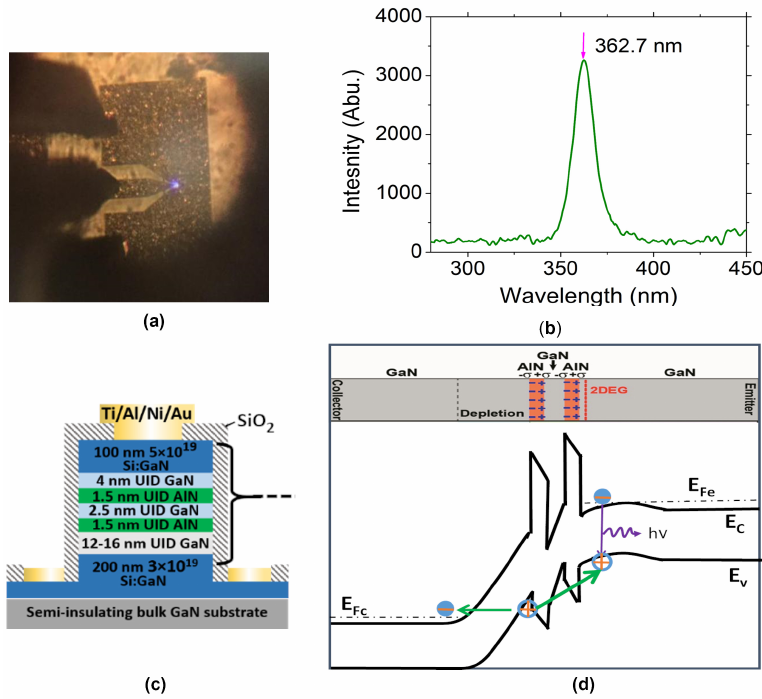
Figure 1. ( a ) Unipolar near-UV EL. ( b ) Spectrum of the EL emission. ( c ) Structure of GaN/AlN/GaN heterostructure stack. ( d ) An illustration of the hole generation process and the cross-bandgap optical